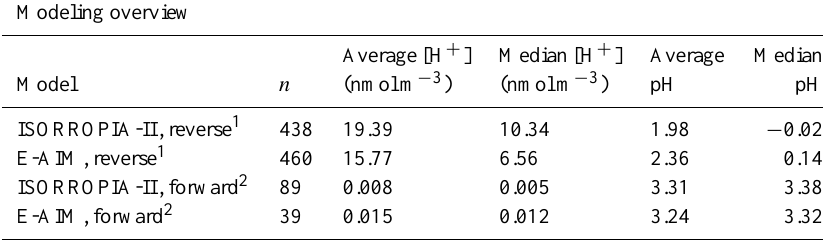
Table 2. Overview of modeling outputs and criteria. Modeling overview